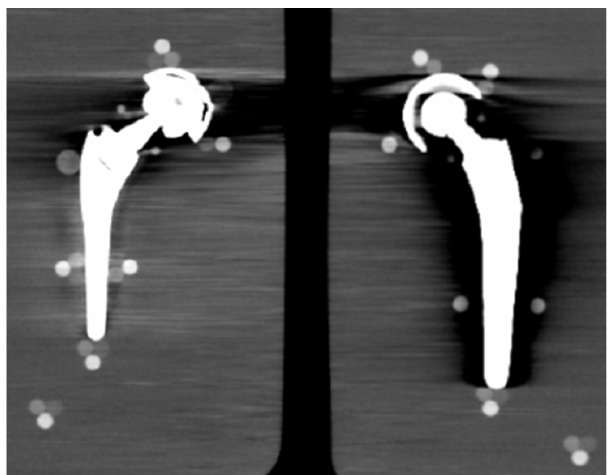
Figure 4. SS unilateral configuration, coronal reconstruction (bone CT visualization window WL:300, WW:1500 ( a ) VMI reconstructed at 90 keV; and ( b ) VMI reconstructed at 90 keV + MARS.